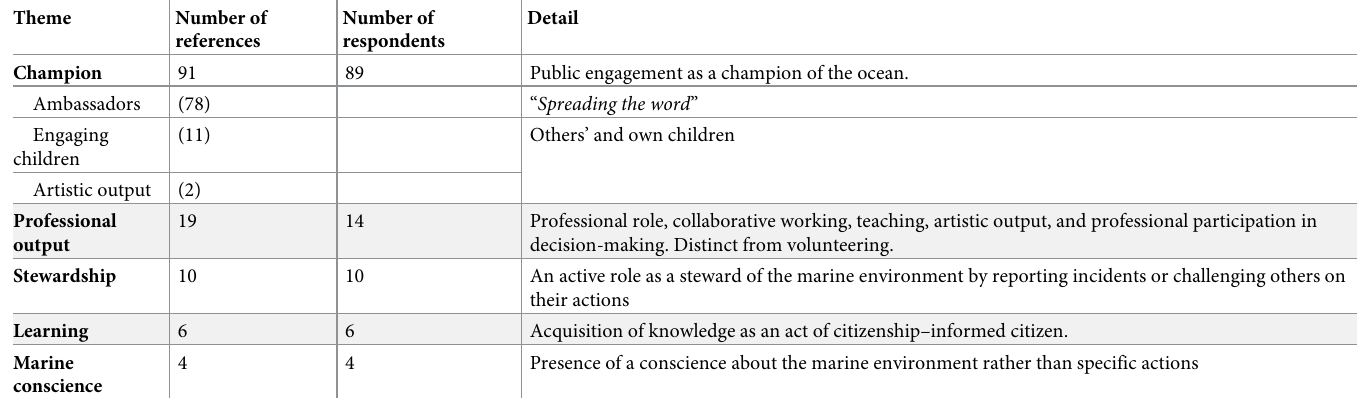
Table 2. Additional marine citizenship actions. Additional actions identified by marine citizens in a free text question indicate an important social capital dimension to marine